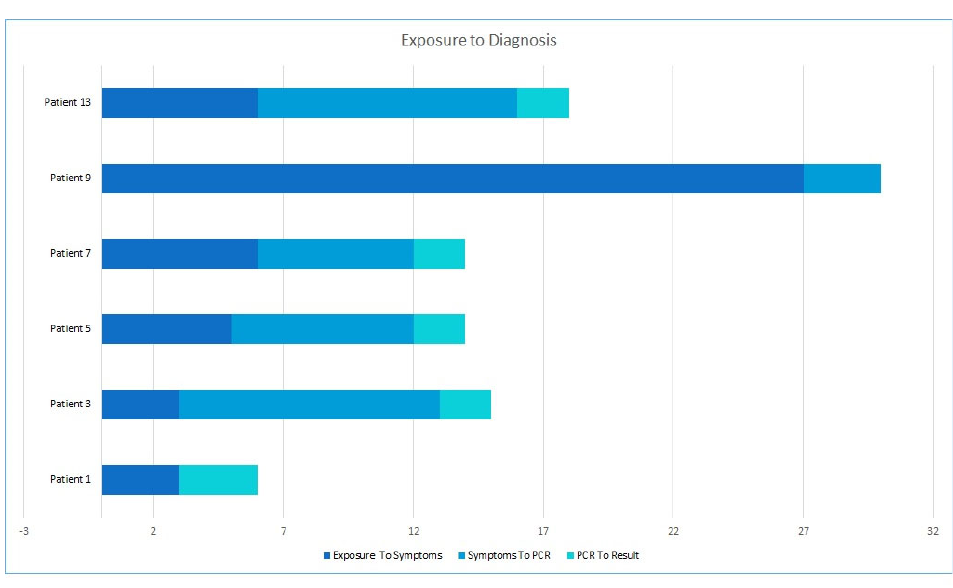
Figure 3. Patient journey from exposure through symptoms and test to